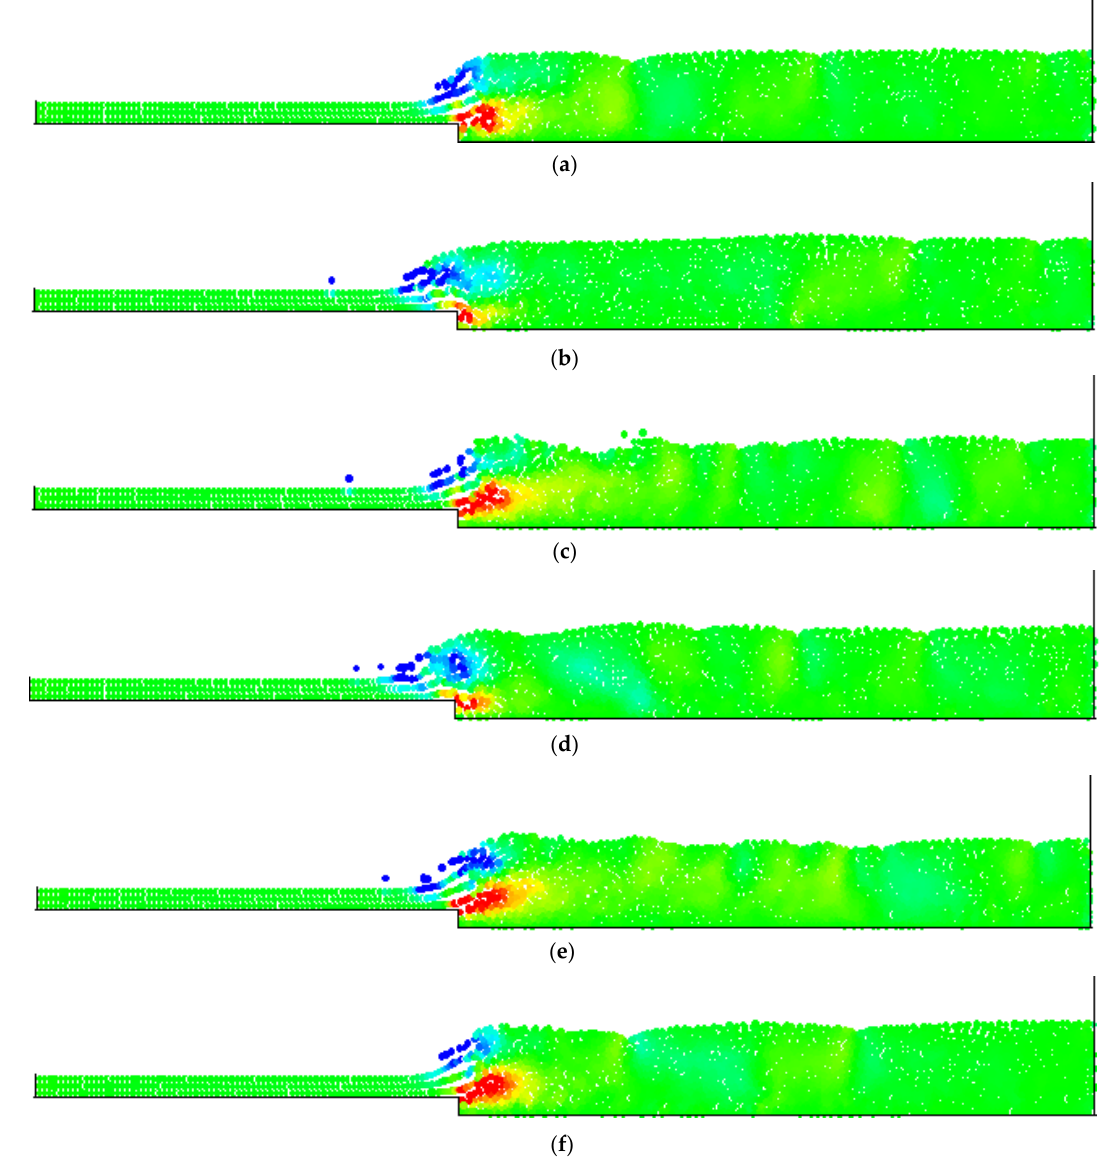
Figure 11. Instantaneous SPH vorticity field in the SPH simulation of Test T6: ( a ) t = 30 s; ( b ) t = 40 s; ( c ) t = 50 s; ( d ) t = 60 s; ( e ) t = 70 s; and ( f ) t = 80 s. Colour scale is the same as in Figure 7.